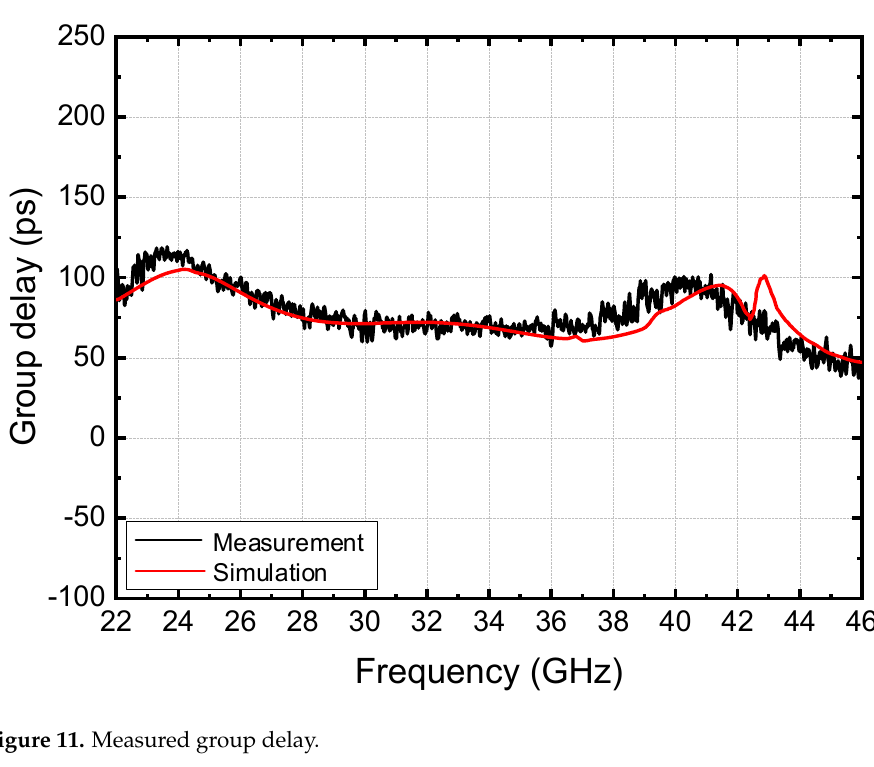
Figure 11. Measured group delay.